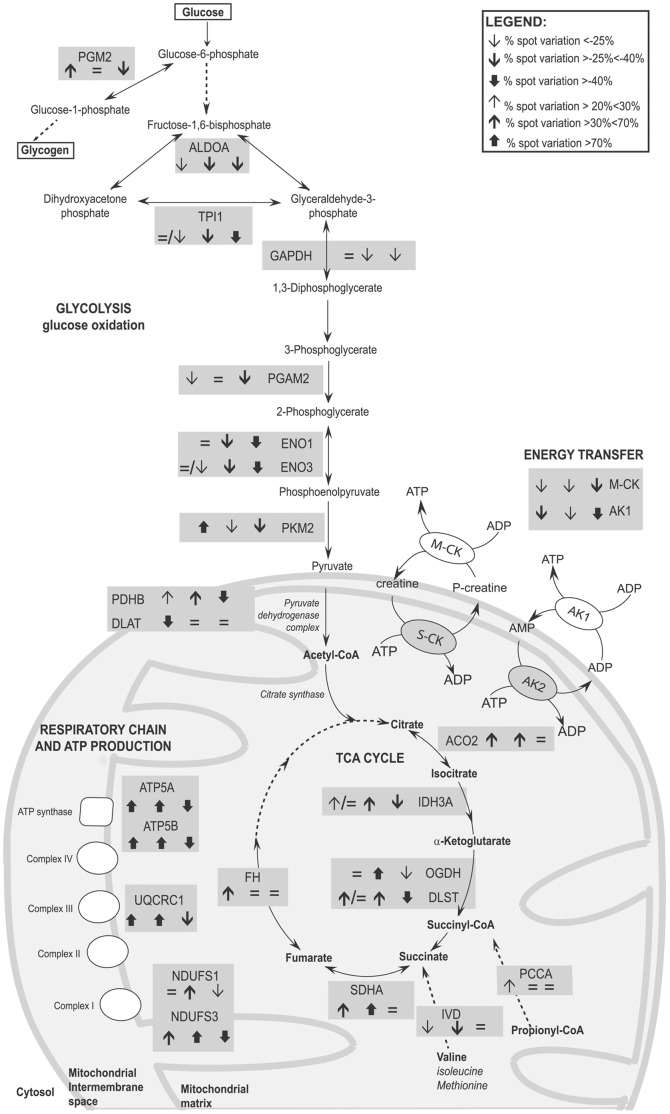
Schematic representation of metabolic enzymes deregulated in gastrocnemius, tibialis anterior and diaphragm muscles.Grey rectangles contain gene names and arrows indicate the protein trend in gastrocnemius, tibialis anterior and diaphragm, respectively. The arrows direction indicates up- and down-regulation, the thickness the % of spot variation.  = /↓ or  = /↑ indicate the differential expression of isoforms of the same protein in a given muscle (for details see Table S1).